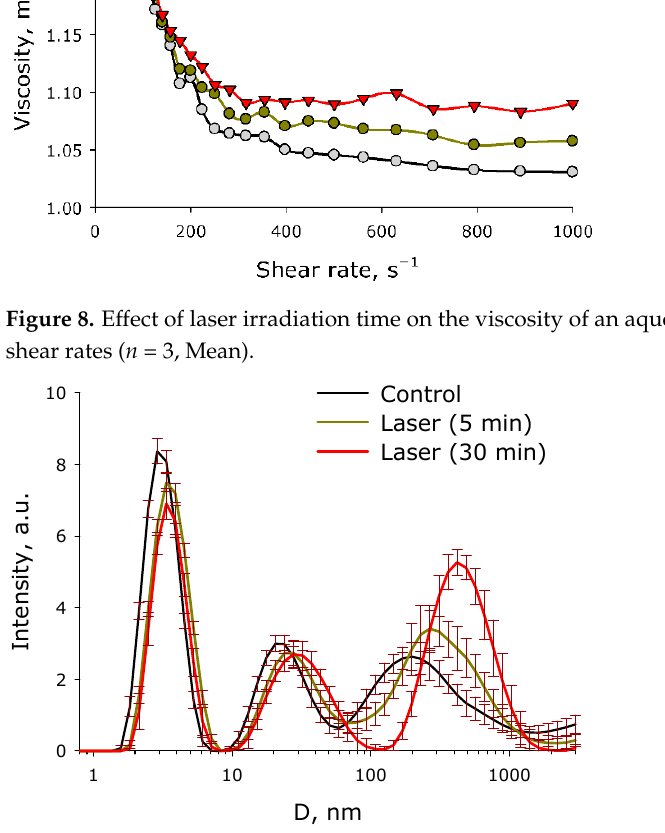
Figure 9. Effect of laser irradiation time on the evolution of the size distribution of BSA and its aggregates in aqueous solution ( n = 5, Mean). The data were obtained by the dynamic light scattering (DLS) method.